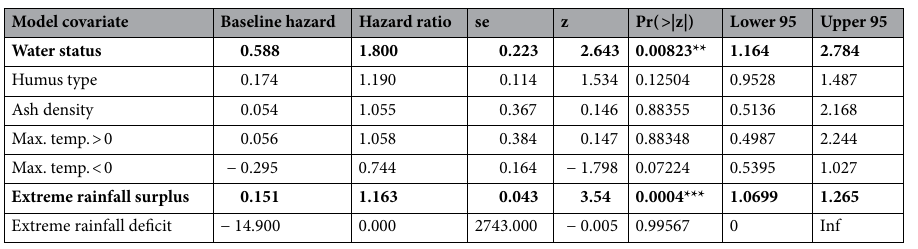
Table 2. Summary statistics from the Cox hazard model. Significant covariates are marked in bold. ** significant at p<0.01, *** significant at p<0.001.